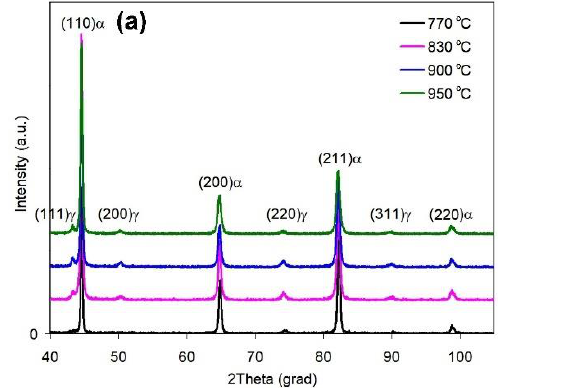
Figure 6. ( a ) XRD patterns of heat-treated specimens and ( b ) effect of austenitizing temperature on the volume fraction of RA and carbon content in RA.